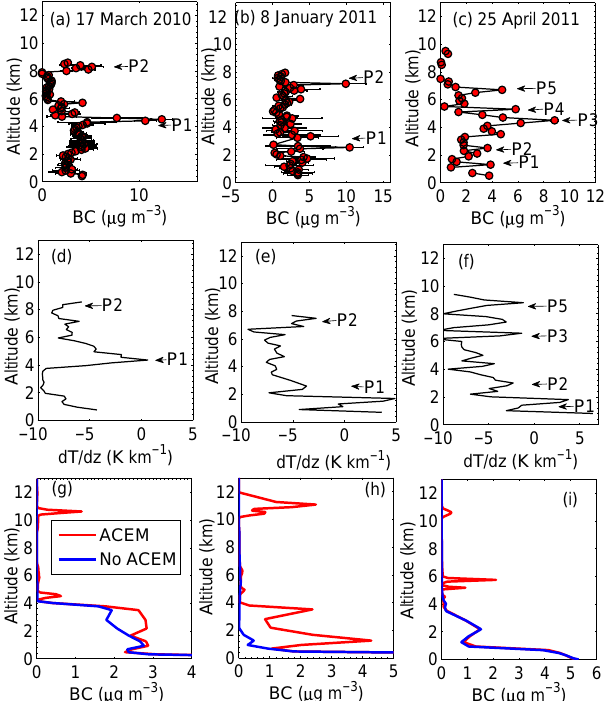
Figure 2. Observed vertical profile of BC over Hyderabad obtained from balloon measurements on (a) 17 March 2010, (b) 8 Jan- uary 2011 and (c) 25 April 2011. The high-altitude BC peaks in each profile are identified by P1 to P5. Observed vertical profile of d T/ d z (Kkm − 1 ) over the Hyderabad region obtained from bal- loon measurements on (d) 17 March 2010, (e) 8 January 2011 and (f) 25 April 2011. The locations corresponding to high-altitude BC peaks are identified by P1 to P5. Model-simulated vertical profile of BC over the area in the vicinity of the balloon flight region for “No ACEM” (blue line; control run) and ACEM (red line; runs with prescription of aircraft BC emissions) on (g) 17 March 2010, (h) 8 January 2011 and (i) 25 April